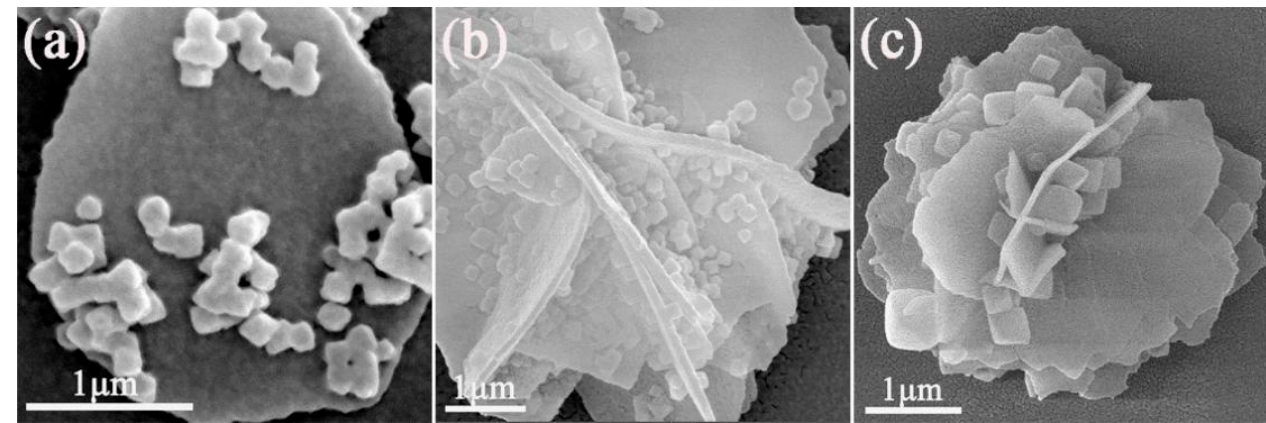
Figure 7. SEM morphologies of Ce/UN composites: ( a ) 350 °C 1-Ce/UN; ( b ) 400 °C 1-Ce/UN; ( c ) 450 °C 1-Ce/UN.